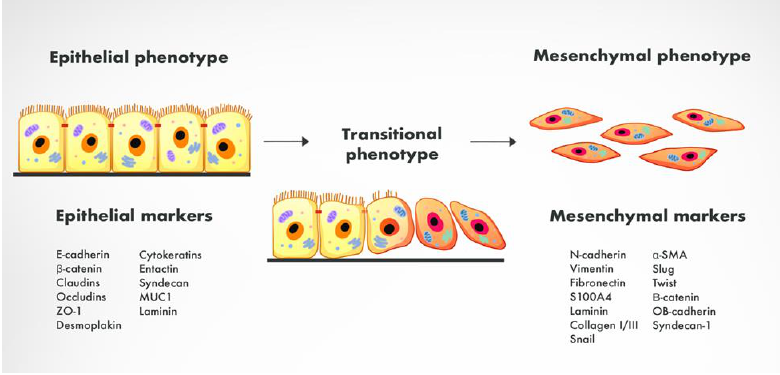
Figure 1. The process of epithelial-mesenchymal transition with specific epithelial and mesenchymal